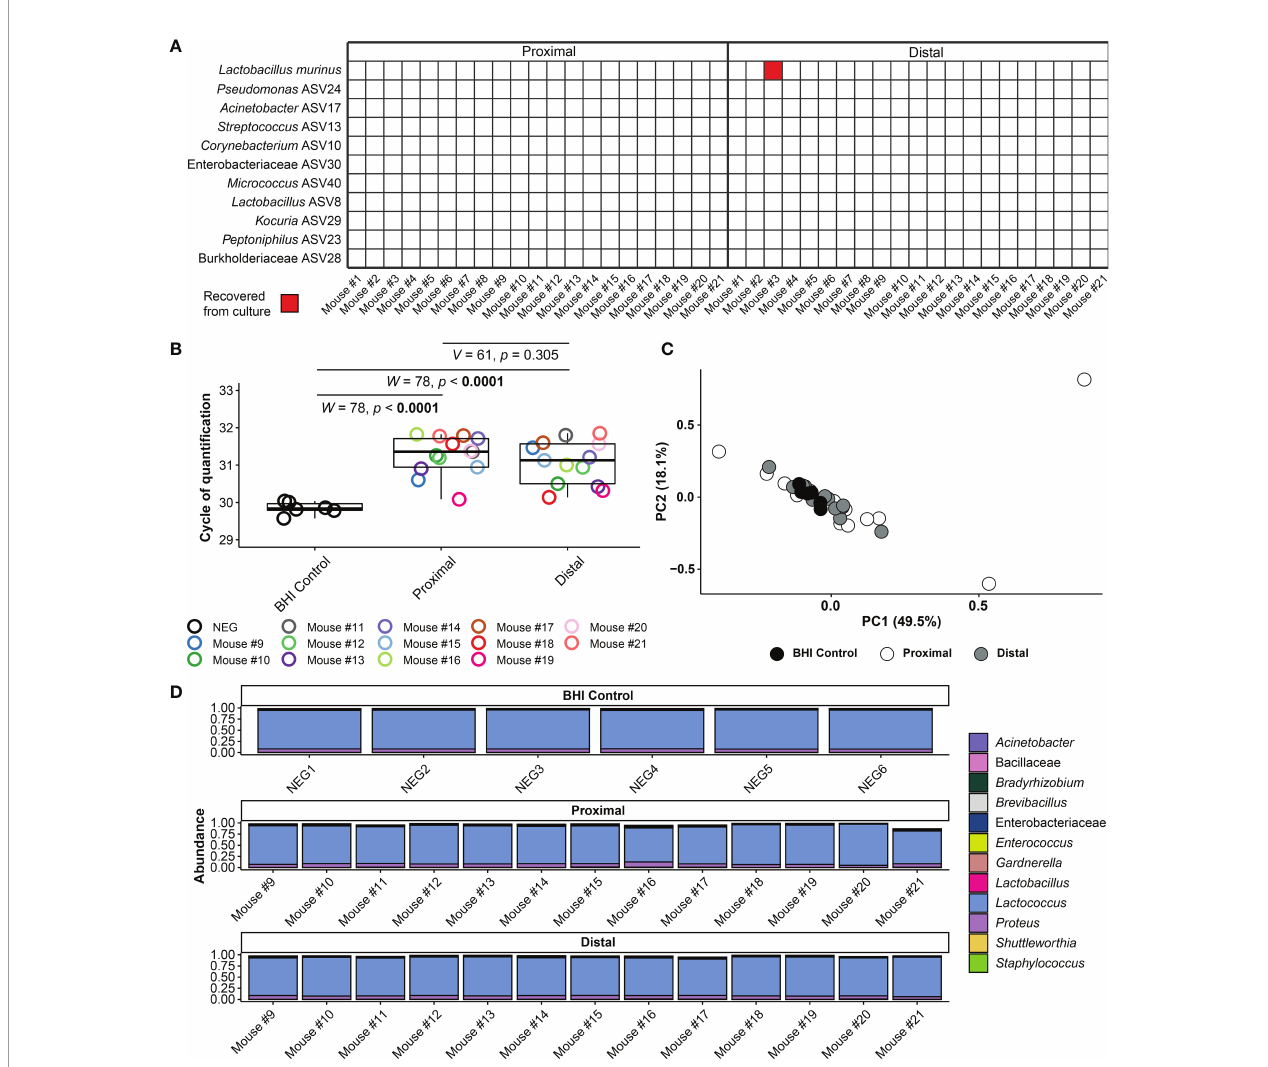
FIGURE 5 | Amniotic fl uid culture and blank control 16S rRNA gene qPCR and sequencing results. (A) Bacterial cultivation results for proximal and distal amniotic fl uid samples. (B) Cycle of quanti fi cation values from qPCR on amniotic fl uid culture samples and BHI culture medium controls. (C) Principal coordinate analysis (PCoA) of bacterial relative abundance data from amniotic fl uid samples and BHI culture medium controls. (D) Relative abundance of bacteria in the 16S rRNA gene pro fi les of amniotic fl uid samples and BHI culture medium controls. Bars of identical color within the same sample indicate multiple amplicon sequence variants with the same bacterial taxonomic classi fi